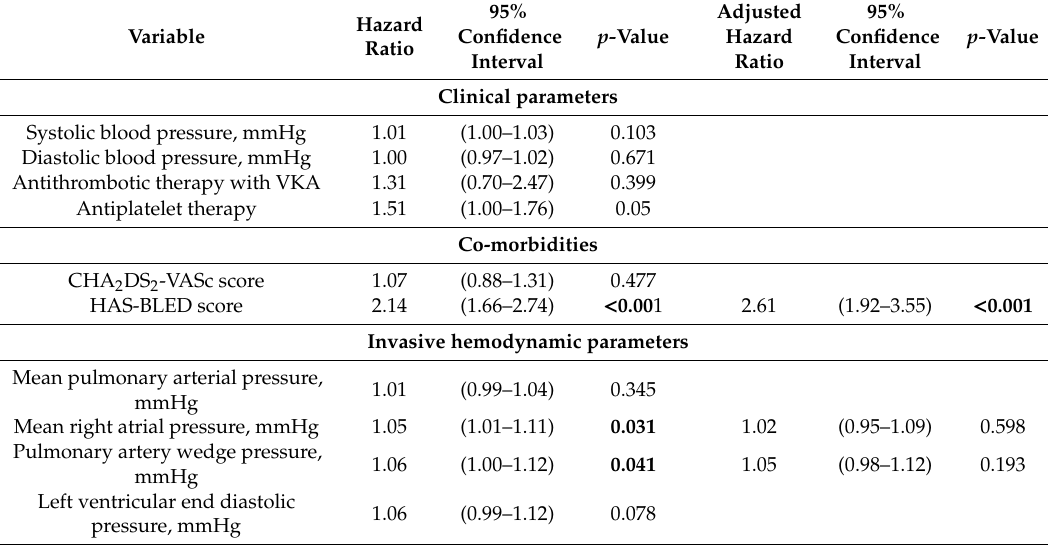
Table 3. Cox proportional hazard model of patients treated with oral anticoagulation ( n = 212) with regard to overall bleeding events ( n =